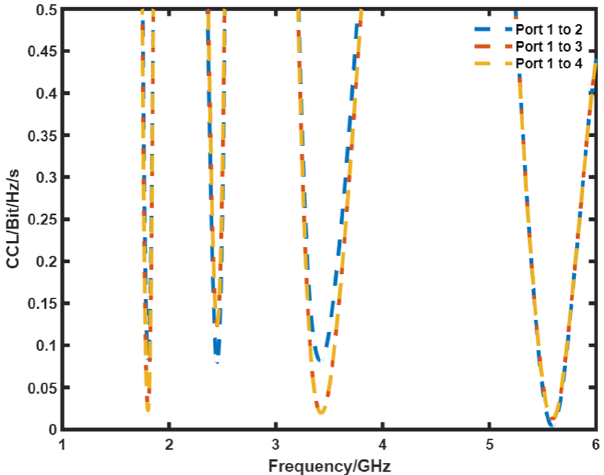
Figure 12. Measured CCL of the DS MIMO antenna.